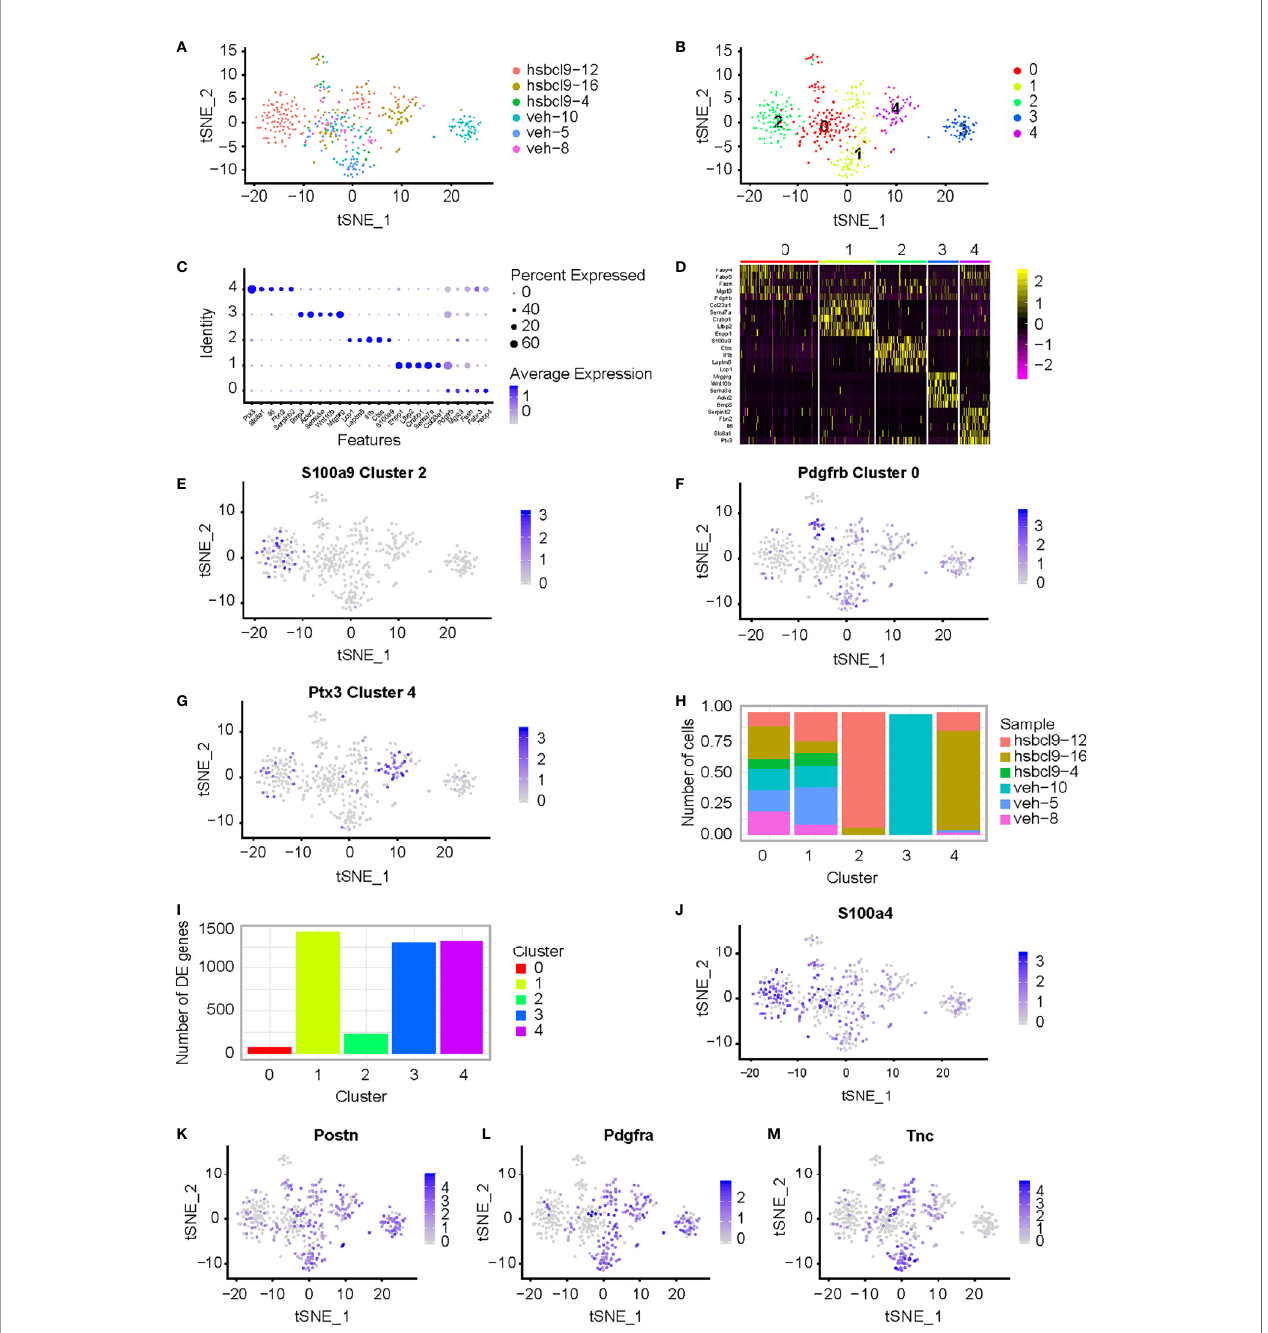
FIGURE 1 | CAF analysis in mouse CT26 tumor in hsBCL9 CT -24 treatment. (A) Single cell RNA-seq of mouse CT26 tumor; t-SNE of the six samples from CT26 tumor mice, which were treated by hsBCL9 CT -24 or by vehicle, were collected. (B) t-SNE plot expression of marker genes for the fi ve different markers of tumor cell de fi ned above each panel color-coded by their associated cluster. Five clusters high quality cells were collected for further analyses. (C) Bubble plots express different marker genes according to each cluster high speci fi c expression gene separate different cells. (D) Five cluster cells were analyzed for different genes with heatmap. (E – G) Expression of marker genes for the cell types de fi ned above each cluster; S100a9 , Pdgfrb , and Ptx3 , highly expressed in clusters 2, 0, and 4, respectively. (H, I) Different clusters present difference of cell numbers and genes among clusters 0, 1, 2, 3, and 4. (J – M) Expression of CAF marker genes for the cell types de fi ned above each cluster; S100a4 , Postn , Pdgfra , and Tnc , highly expressed in clusters 2, 0, and 4, respectively. Wilcoxon rank sum test was used for statistical